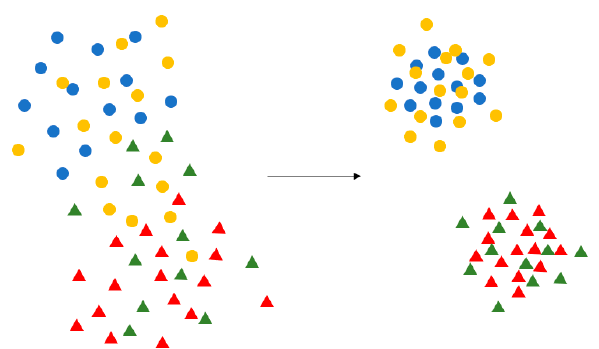
Figure 10. Purpose of Center Loss + MMD.